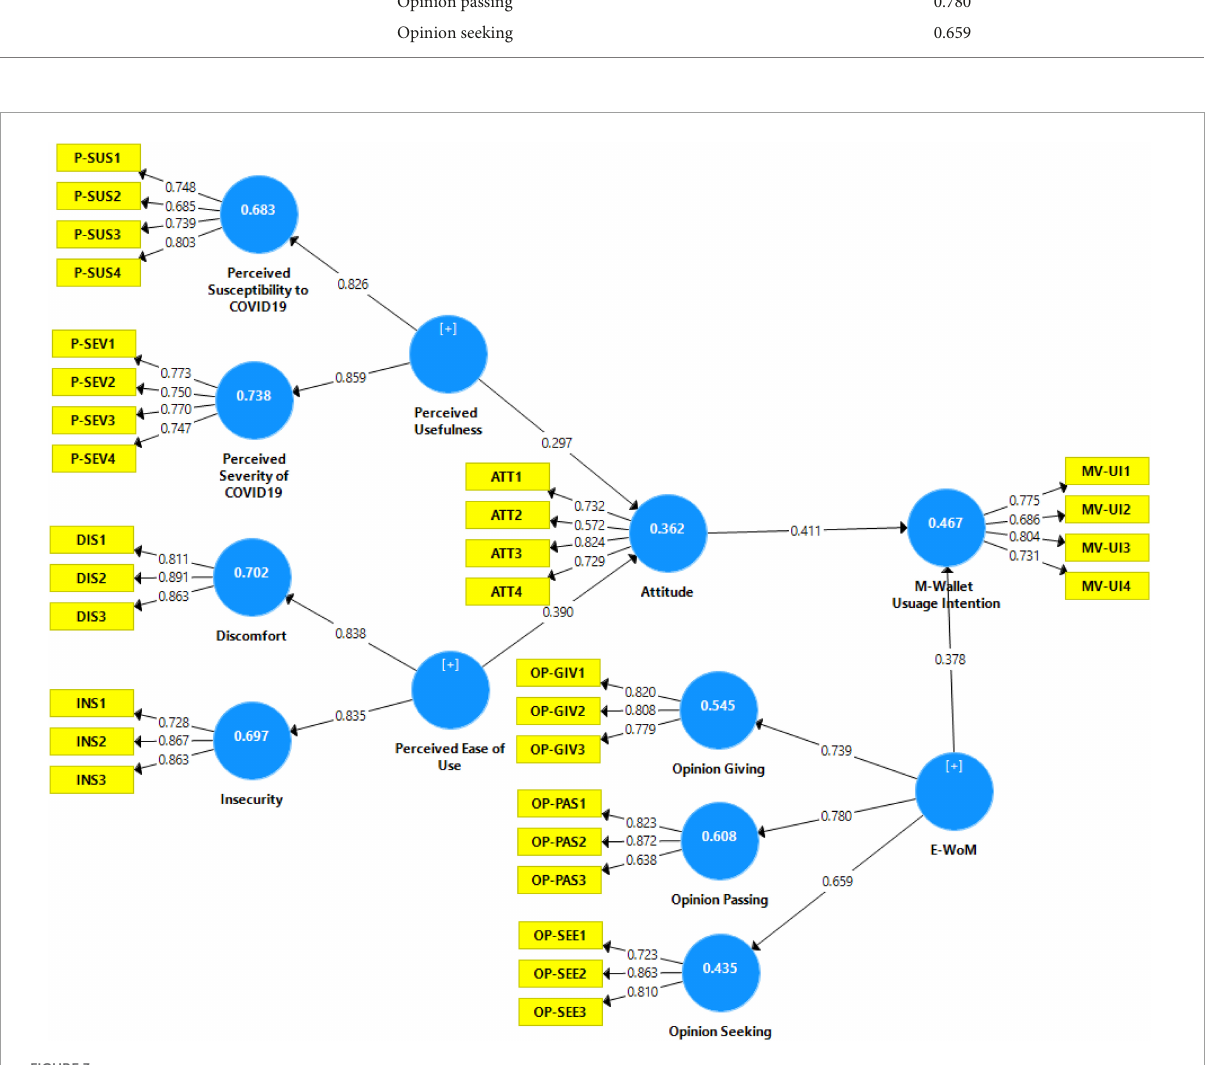
amount of variance ( R 2 = 0.362) in users’ attitudes toward using m-wallet. In addition, attitude moderately explains the variance in users’ intention toward using m-wallet ( R 2 =